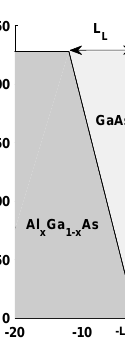
Figure 1. Geometric scheme of the GaAs/Ga 1 − x Al x As double semi-V-shaped quantum